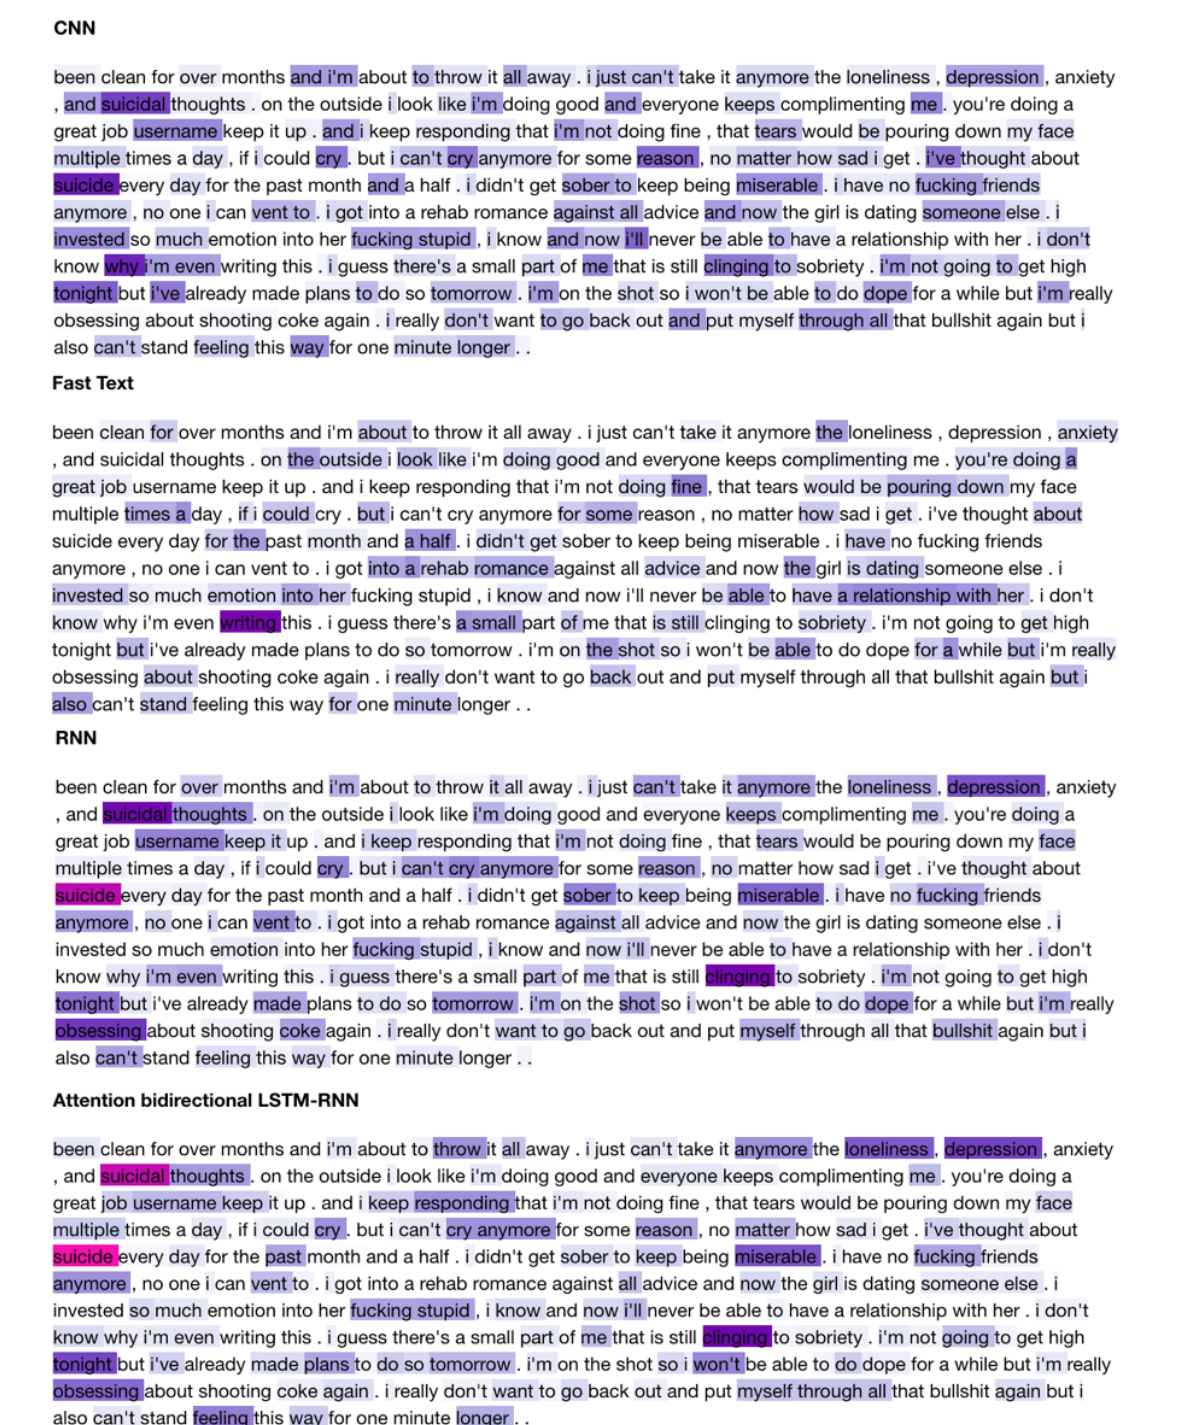
Figure 2. Visualization of word importance as determined from the resultant word embeddings learned from scratch by the neural network models for